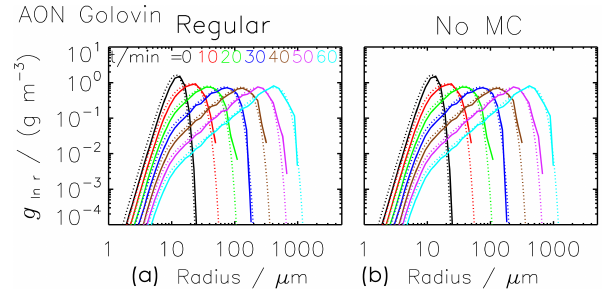
Figure 13. Mass density distributions obtained by AON for the Golovin kernel from t 0 to 60min every 10min (from black to = cyan; see legend). The dotted curves show the reference solution; the solid curves show the AON simulation results (ensemble av- erages over 50 realisations). The default settings are probabilistic singleSIP-init with weak threshold η 10 − 9 , κ 40 and (cid:49)t 1s. = = = The left panel shows results of the regular algorithm and the right panel those of a version disregarding multiple collections.